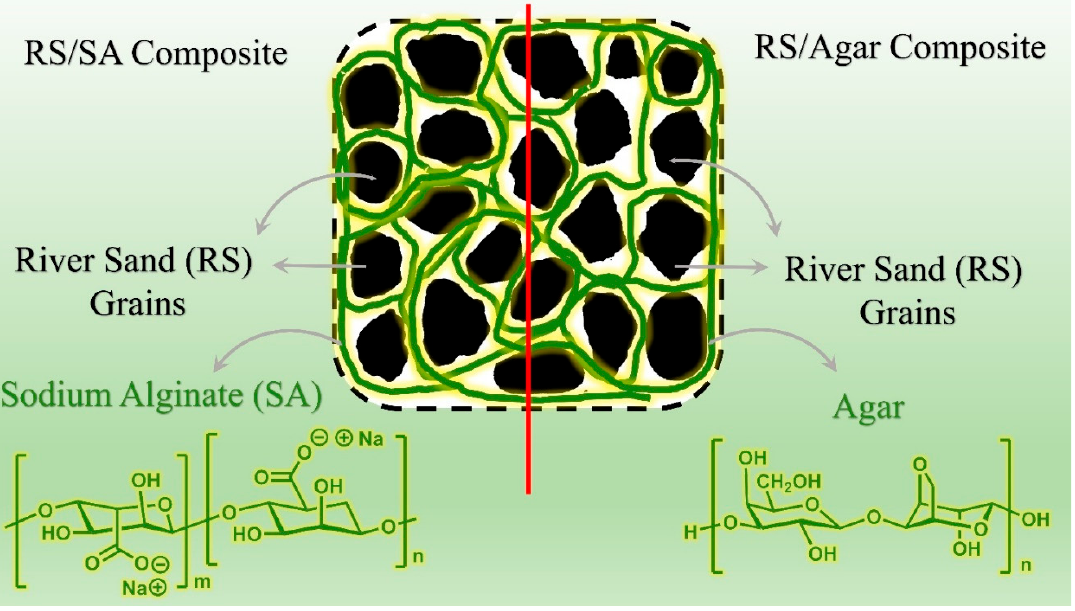
Figure 12. Structure of river sand, sodium alginate and agar and their interaction.